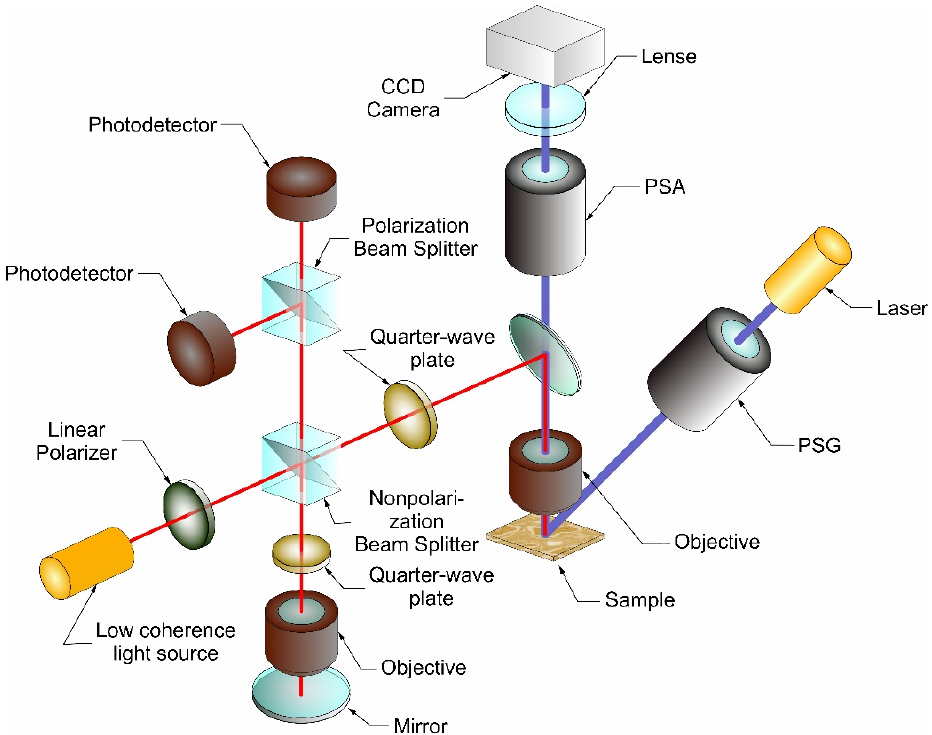
Figure 4. Combined PS-OCT and MMIP schematic.